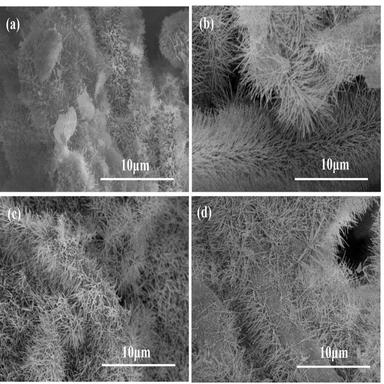
Microstructures of the MFWs: (a) MFW1, (b) MFW2, (c) MFW3, (d) MFW4.